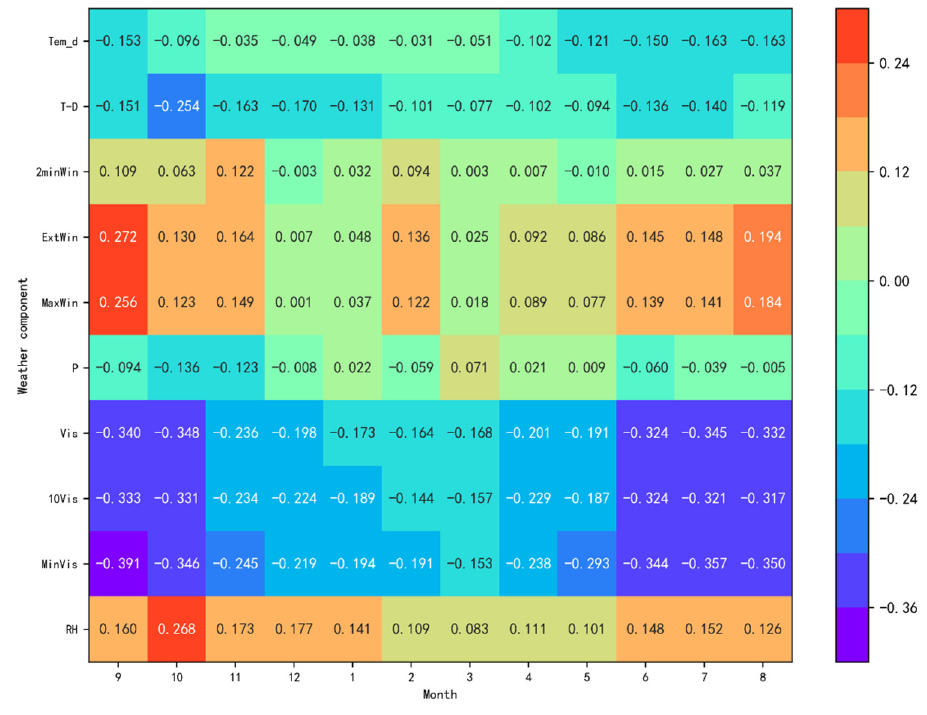
Figure 3. Monthly average correlation coefficients between each reference weather component and